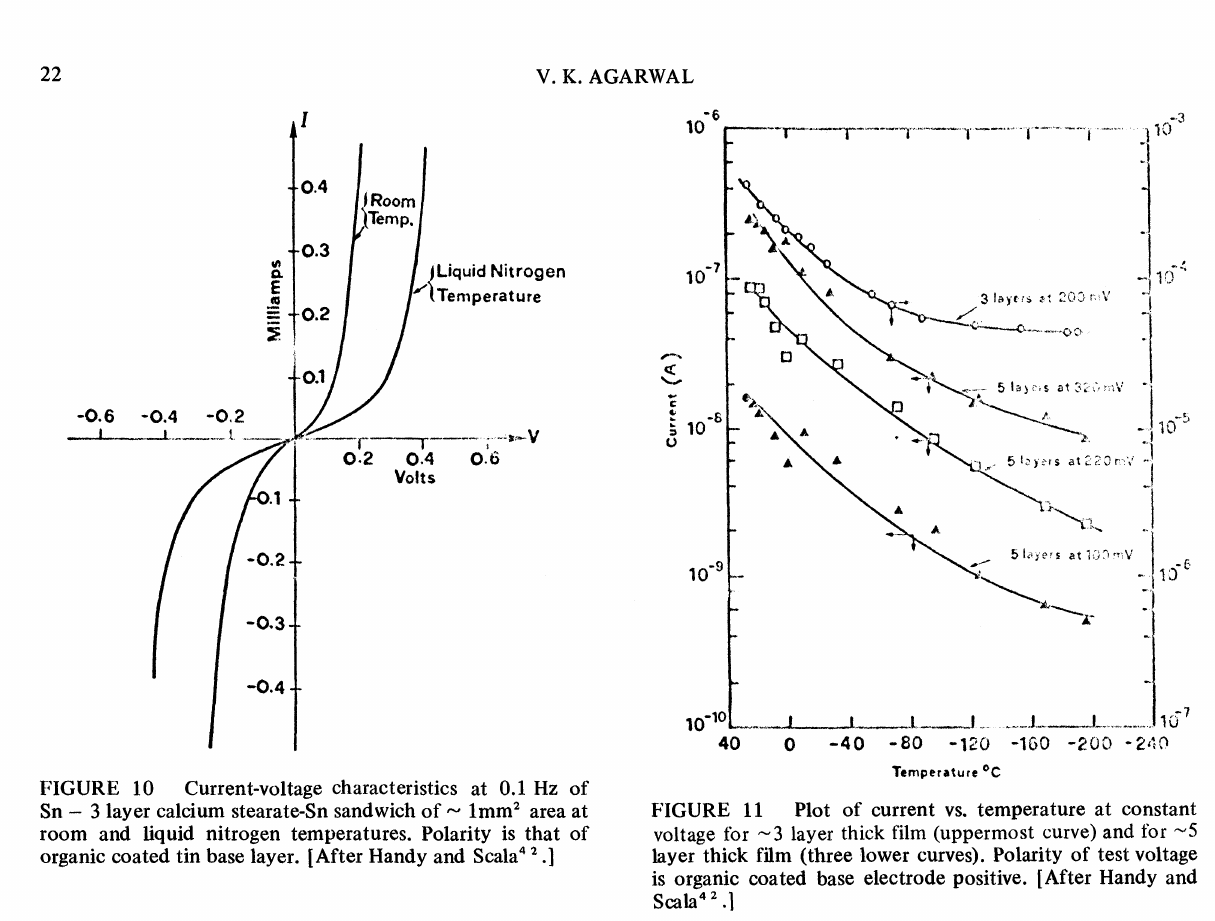
FIGURE 11 Plot of current vs. temperature at constant voltage tbr -3 layer thick film (uppermost curve)and tbr 5 layer thick film (three lower curves). Polarity of test voltage is organic coated base electrode positive. [After Handy and